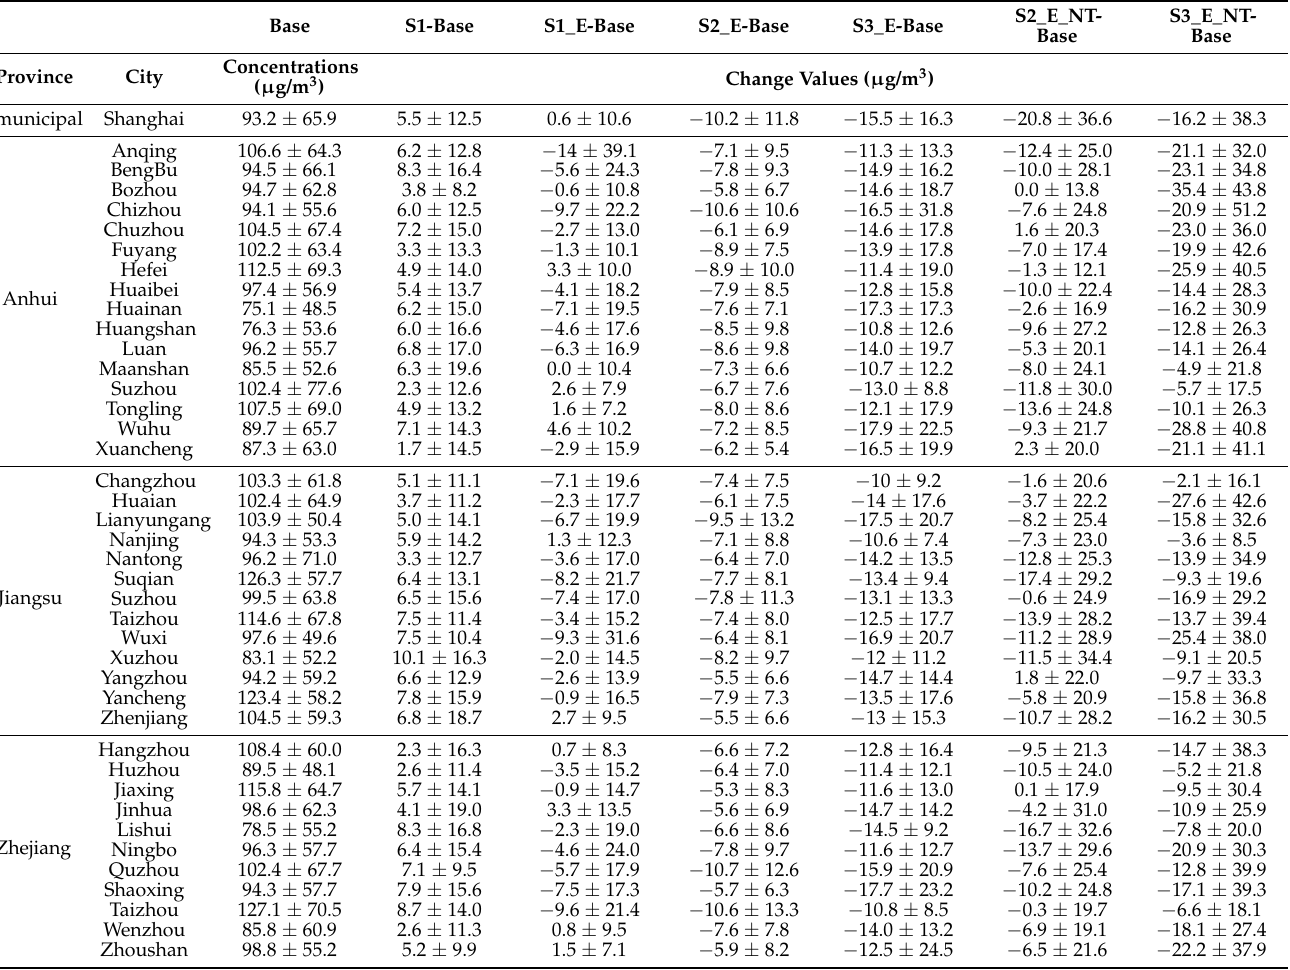
Table 4. Predicted average change values of summer O 3 concentrations under the 6 control sce- narios relative to the baseline in 41 main cities of YRD in 2025. The results of the base case are also summarized.